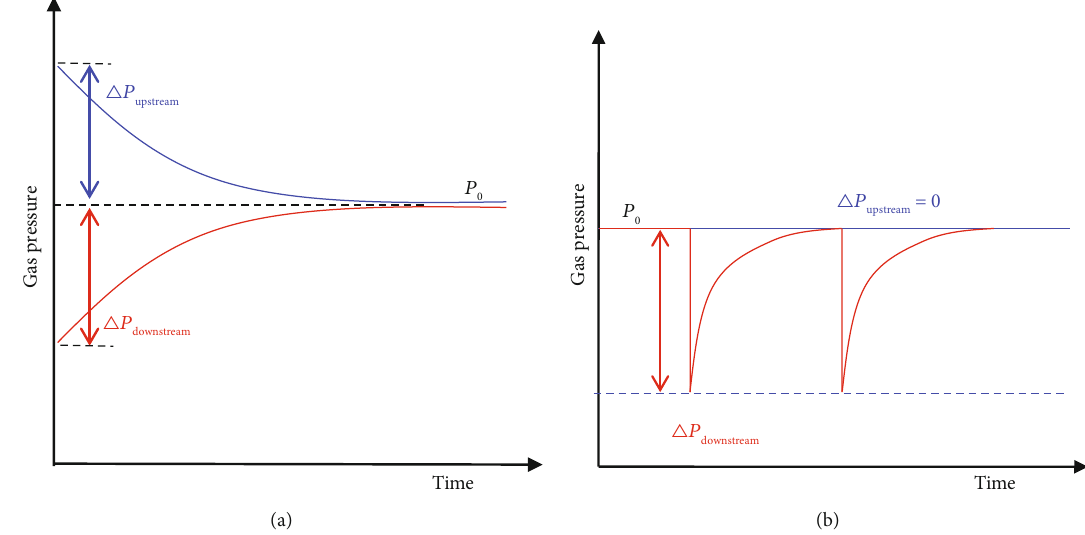
Figure 3: Gas pressure changes of the upstream reservoir and downstream reservoir. (a) Conventional pressure-pulse method; (b) modi fi ed pressure-pulse method.